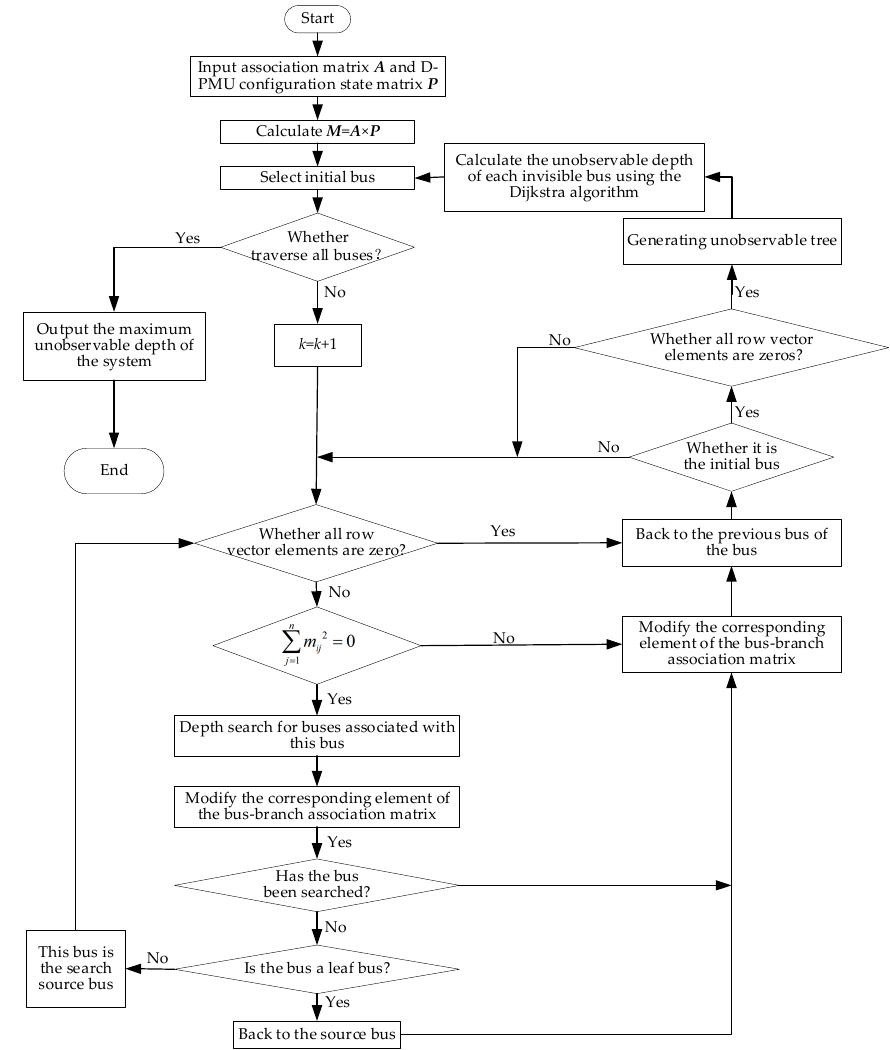
Figure 2. Flowchart for the calculation of unobservable depth.